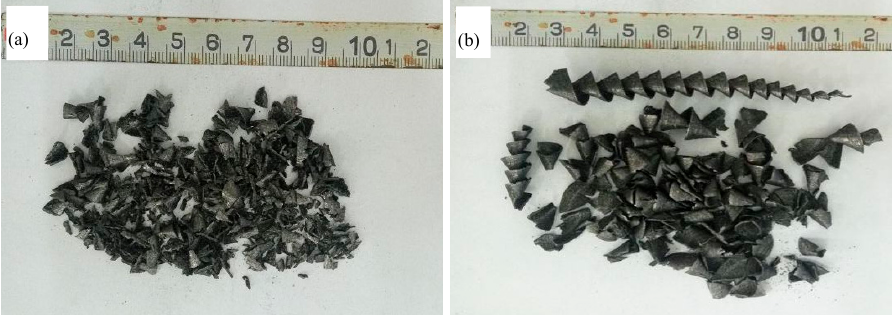
Figure 8. The drilling chips appearance for the Φ 14.5 mm bit diameter with 800 rpm rotating speed and 0.5 mm/rev feed rate: ( a ) HT250 and ( b ) QT450.